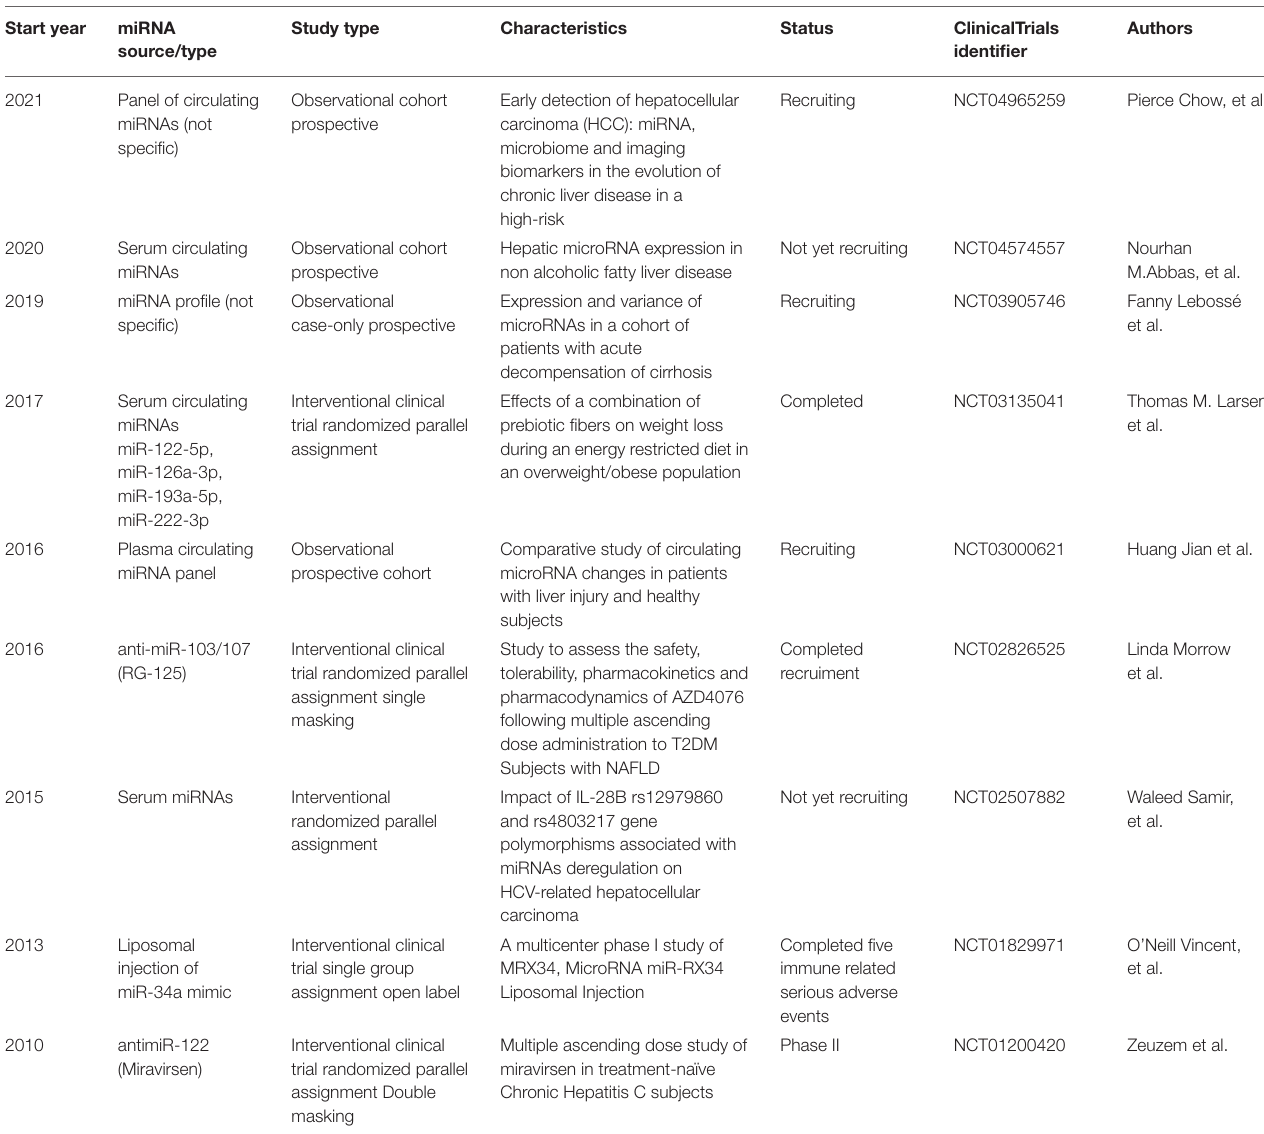
TABLE 2 | Clinical trials using miRNAs for hepatic